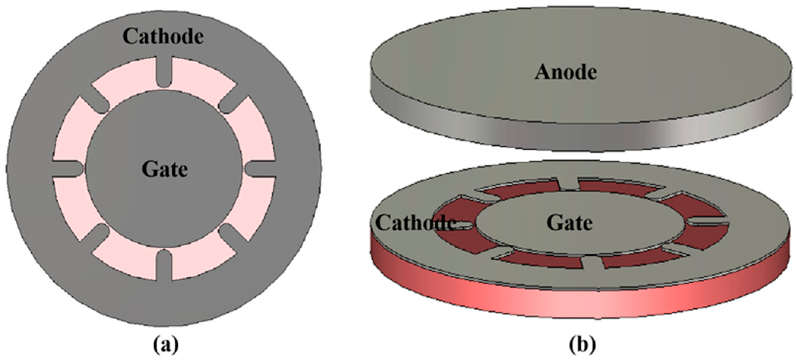
Figure 5 . ( a ) Top view of the symmetrical structure. ( b ) Three-dimensional schematic.